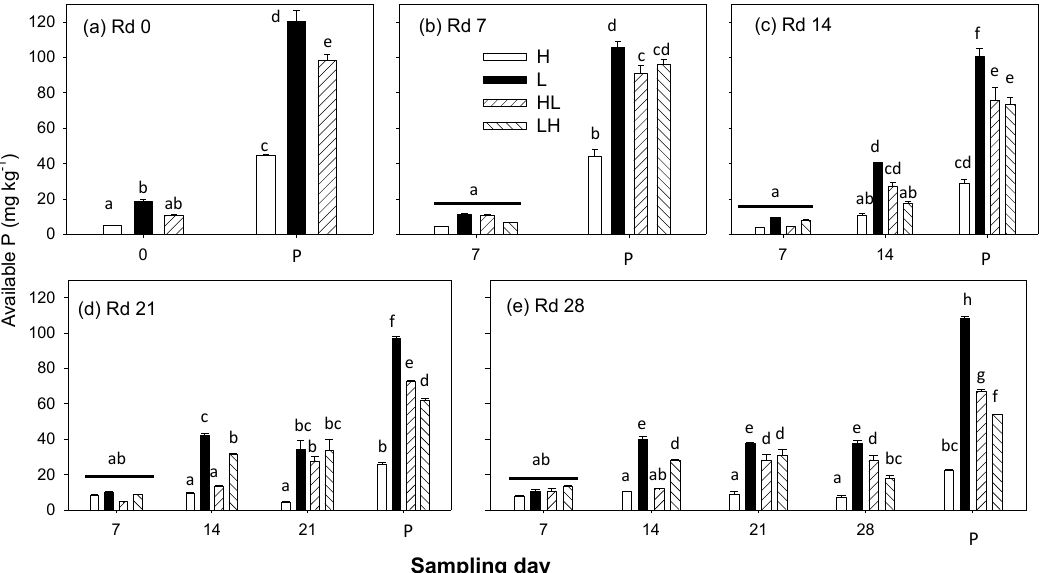
Fig. 2: Available P concentration on days 7, 14, 21, 28 and at plant harvest (indicated by P) in treatments with only high C/N residue added (H), only low C/N residue added (L), high followed by low C/N (HL) or low followed by high (LH) where the second residue was added the same day as the first (a) or 7 (b), 14 (c), 21 (d) or 28 (e) days after the first (Rd0, Rd7, Rd14, Rd21, Rd28) (n=4 ± standard error). Columns within a treatment group with different letters are significantly different (P≤ 0.05). Tab. 3: Shoot, root and total dry weight (g pot -1 ) of wheat 28 days after the second residue addition in treatments with only high C/N residue added (H), only low C/N residue added (L), high followed by low C/N (HL) or low followed by high (LH) where the second residue was added 7, 14, 21 or 28 days after the first (Rd7, Rd14, Rd21, Rd28) (n=4 ± standard error ). Values followed by different letters are significantly different (P≤